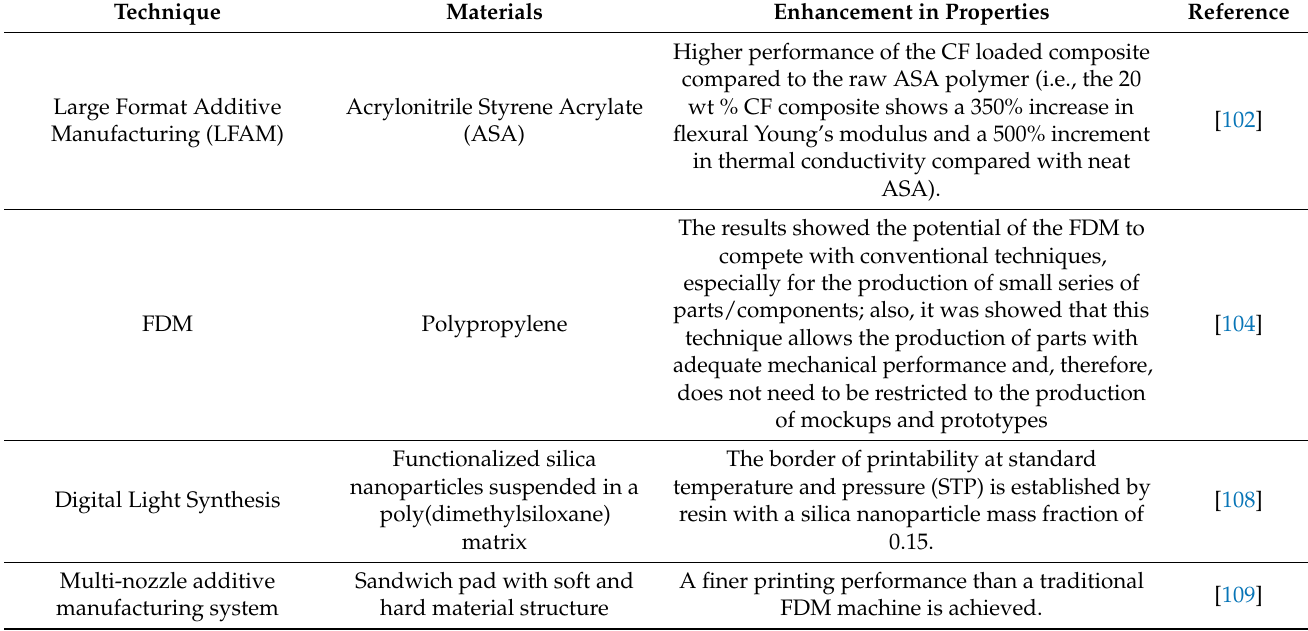
Table 3. Techniques and properties enhanced in polymer